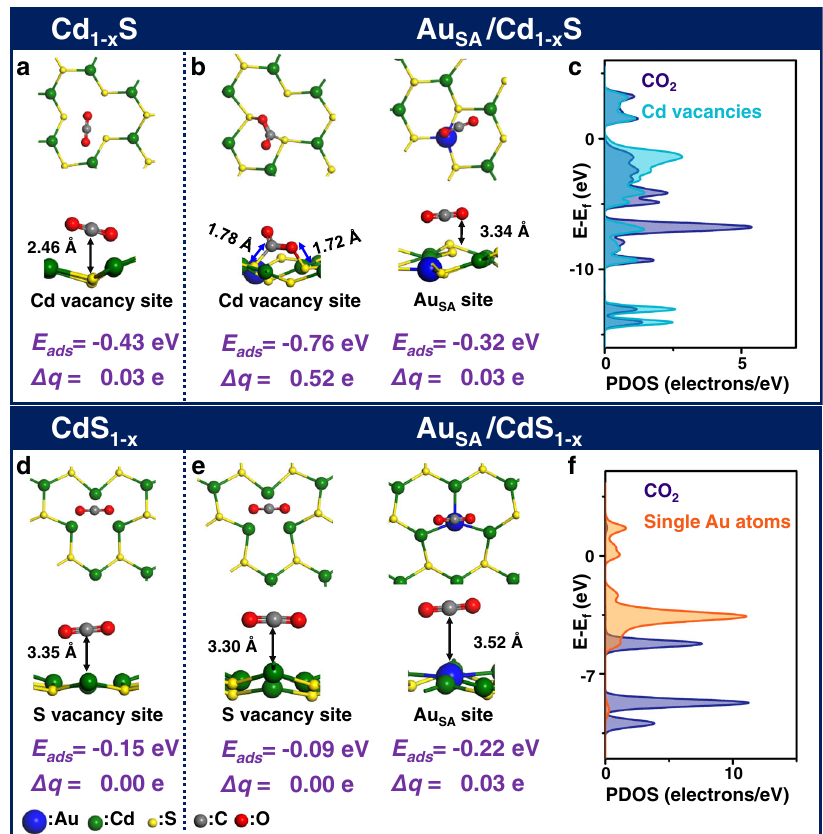
Fig. 5 CO 2 adsorption models on different surfaces. Con fi gurations of CO 2 adsorption : a on Cd 1-x S; b Au SA /Cd 1-x S; d CdS 1-x ; e Au SA /CdS 1-x . PDOS of CO 2 and adsorption site: c . in Au SA /Cd 1-x S; f Au SA /CdS 1-x